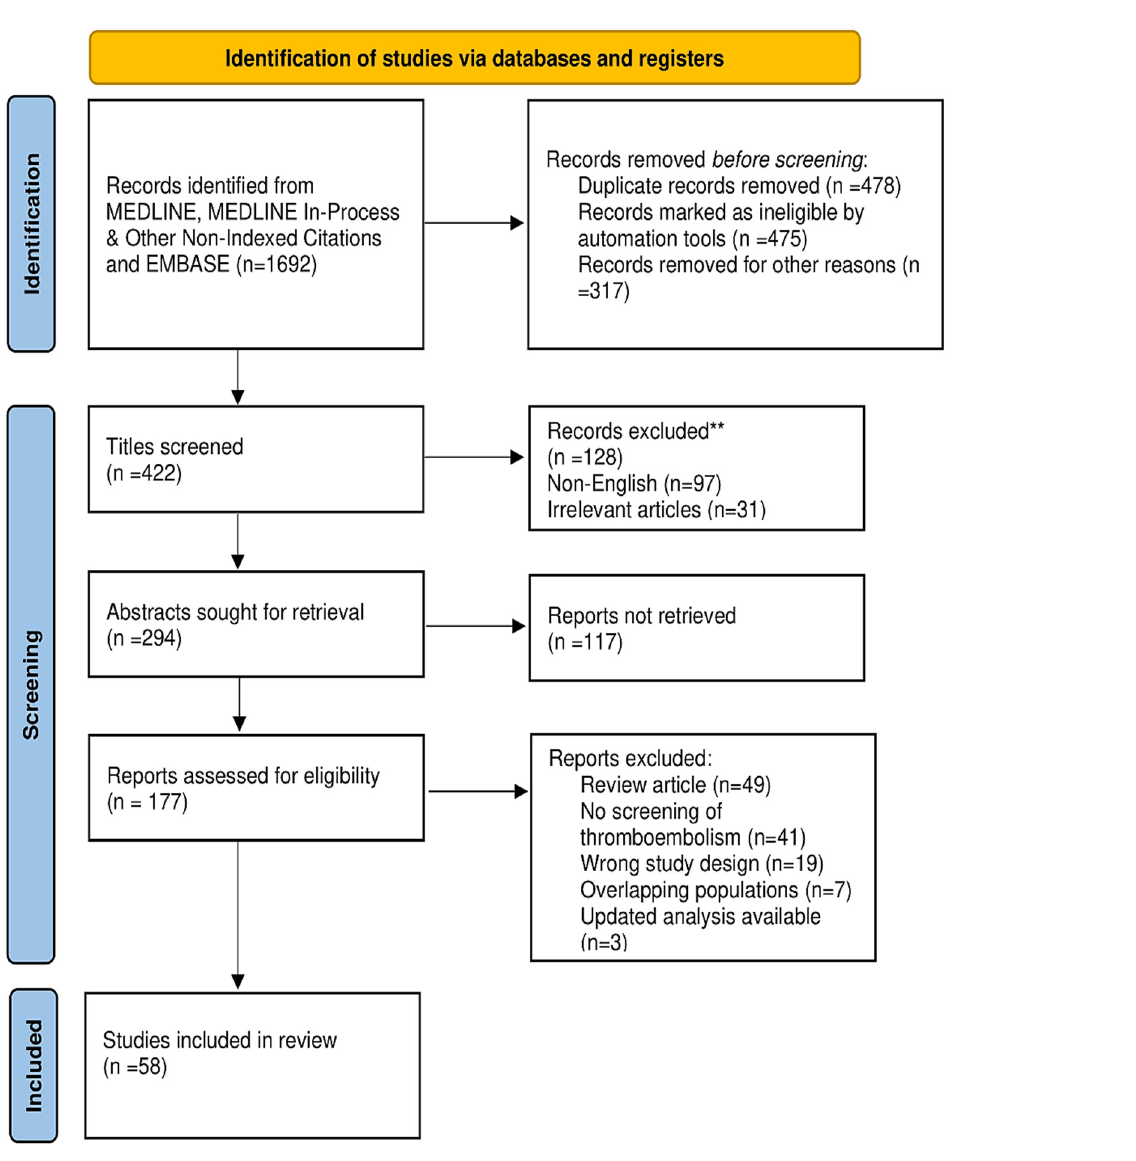
Figure 2. PRISMA 2020 flow diagram.